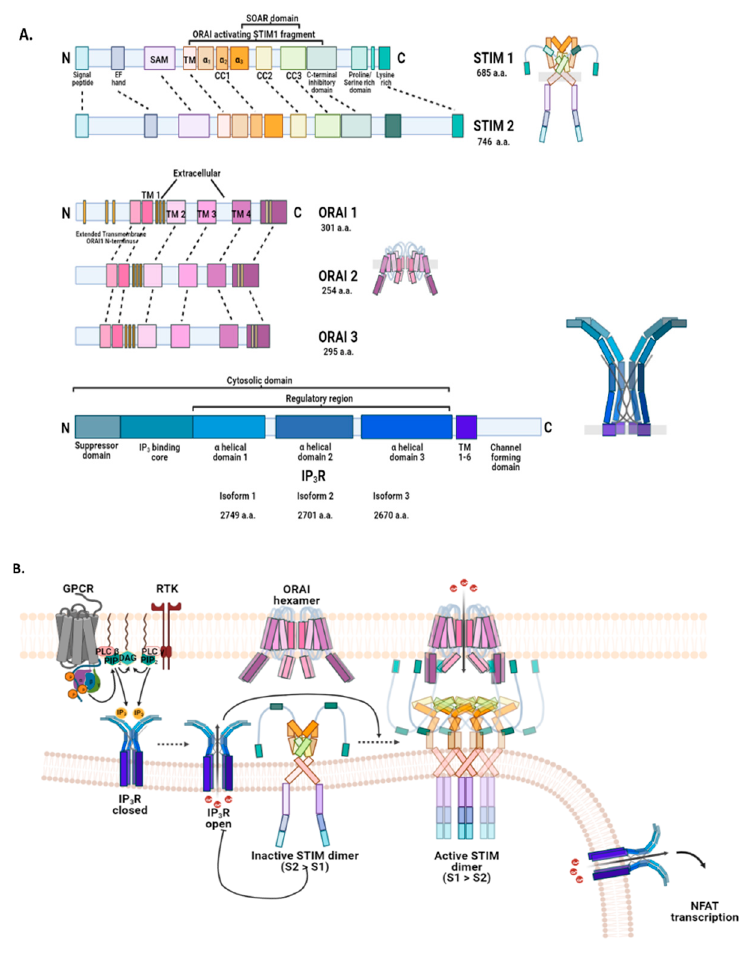
Figure 7. Major molecules in store-operated Ca 2+ entry. ( A ) STIM, ORAI, and IP3Rs are central to the influx of Ca 2+ ions from extracellular space into cytosol re-quired for replenishing the depleted intracellular stores. In humans, STIM has two isoforms. Both, STIM1 and STIM2 have a type I transmembrane structure comprised of a signal peptide at the N-terminus for localization to the ER, an EF-hand motif, and a sterile alpha motif for binding of luminal Ca 2+ ions. SAM is also a site for protein–protein interactions), and a short transmembrane segment followed by three coiled-coiled domains (CC1, CC2, and CC3, that form ORAI-activating STIM fragment or OASF). CC2-CC3 region (or SOAR) is adequate as well for STIM–ORAI interactions [106–109]. The ORAI interacting sites on the domain are hidden in inactive STIM dimers. A Ca 2+ -dependent inhibitory domain, a proline/serine-rich region (polybasic; PBS), and a lysine-rich tail segment are found at the C-terminus. ORAI channels have three isoforms in humans. All the ORAI isoforms have an N-terminal ETON segment (cytosolic), four transmembrane domains, and a cytosolic C-terminus. The structure between TM 1-2 and TM3-4 is exposed to the extracellular space. The yellow vertical bars depict regions of amino acid residues (positive, negative, hydrophobic, or special) that influence ORAI channel pore selectivity. ORAI channel exists as a hexamer that is formed by oligomerization of 3 dimer subunits. Inositol 1,4,5-triphosphate receptor subunits have most of their structure (5 domains) exposed to the cytosol. Each IP3R is formed of four subunits [110–113]. The transmembrane segments and the C- terminus are involved in pore-forming, gate-keeping, and tetramerization; ( B ) Subsequent to the activation of IP3Rs on the ER membrane by ligand IP3 and cytosolic Ca 2+ , STIM dimers are activated